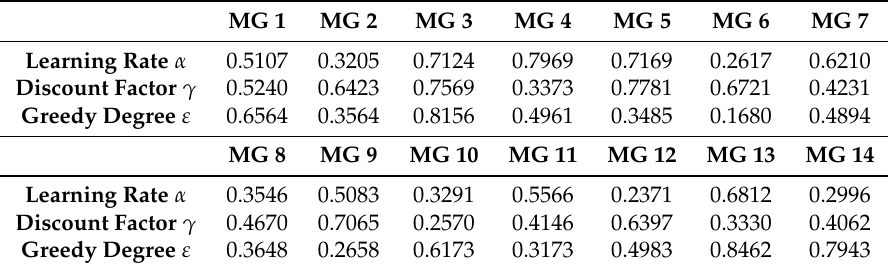
Table A3. Q-Learning Parameters of 14